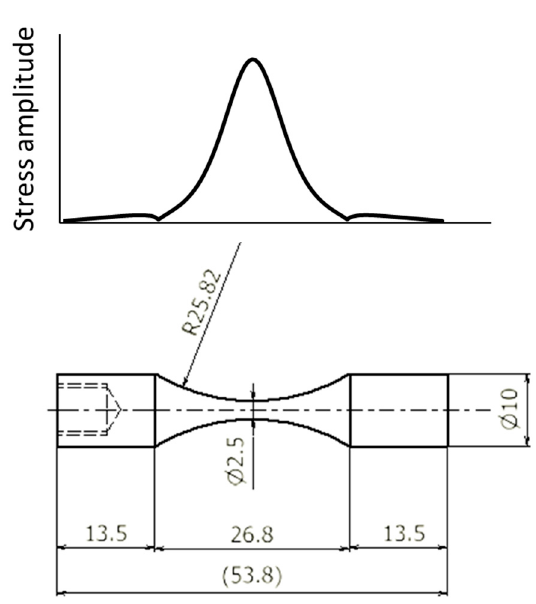
Figure 2. Specimen shape and the profile of the axial stress amplitude, along with the specimen axis.